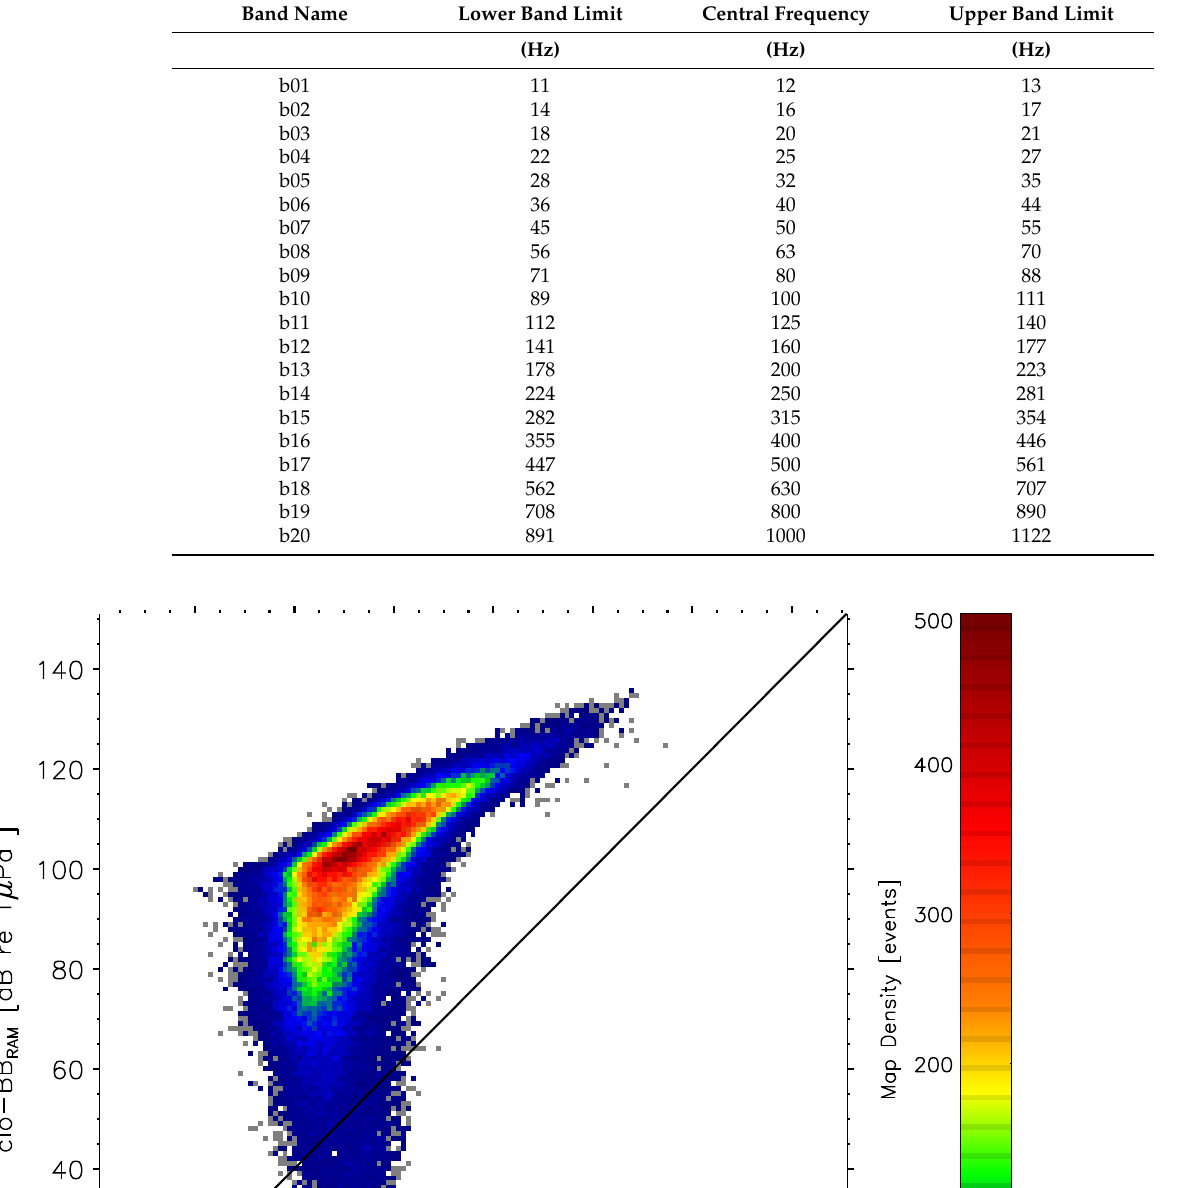
Table 2. 1/3-octave bands.